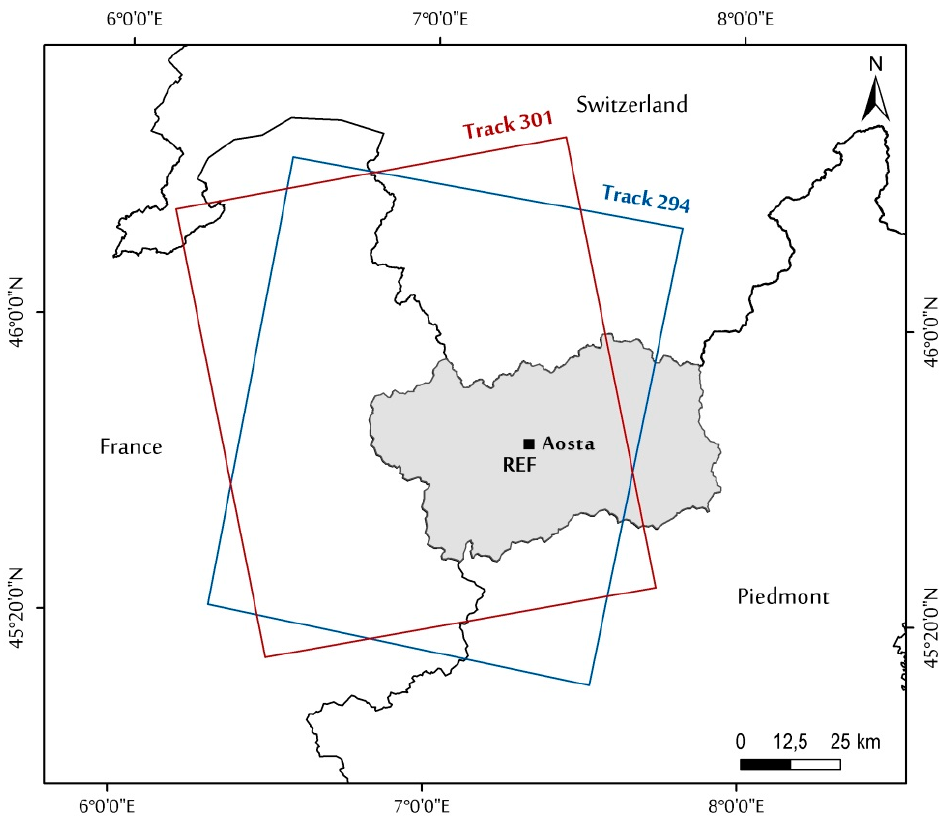
Figure 4. Map of the VDA region study area (in light grey ). The red box represents the extent of ERS-1/2 and ASAR Envisat track in ascending orbit, while the blue box represents the track in descending orbit. The reference point (REF) is located in the Aosta municipality.